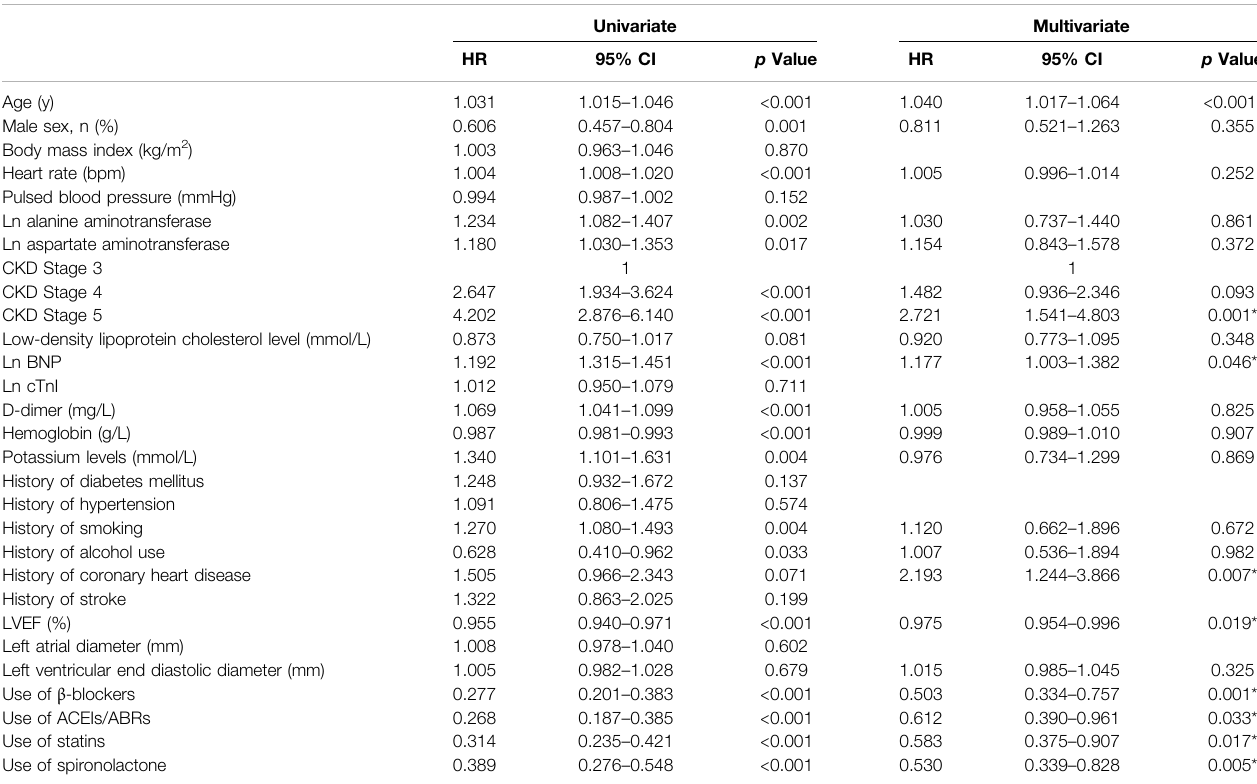
TABLE 3 | Independent predictors for mortality in AMI patients with